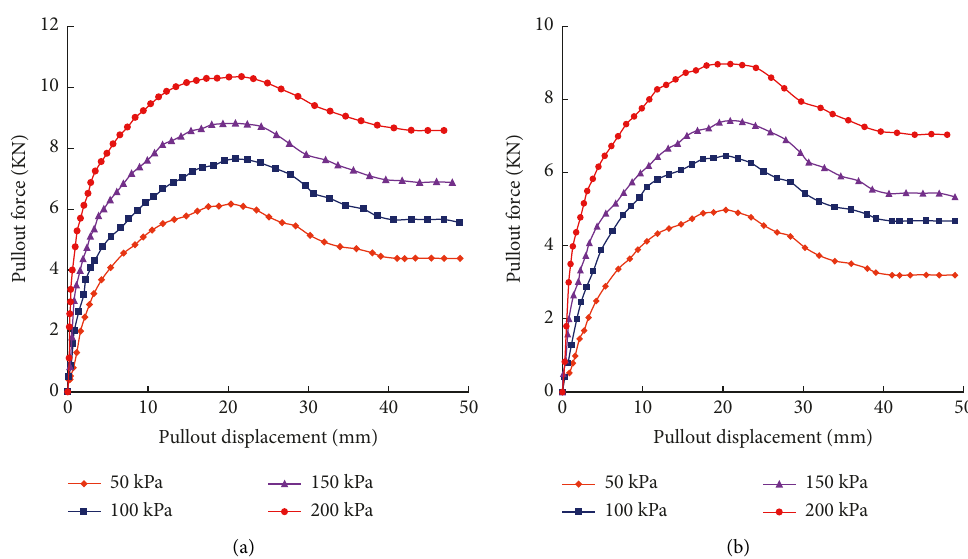
Figure 4: The curve between pullout displacement and force of different transverse rib spacings. (a) s � 35cm. (b) s � 50cm.